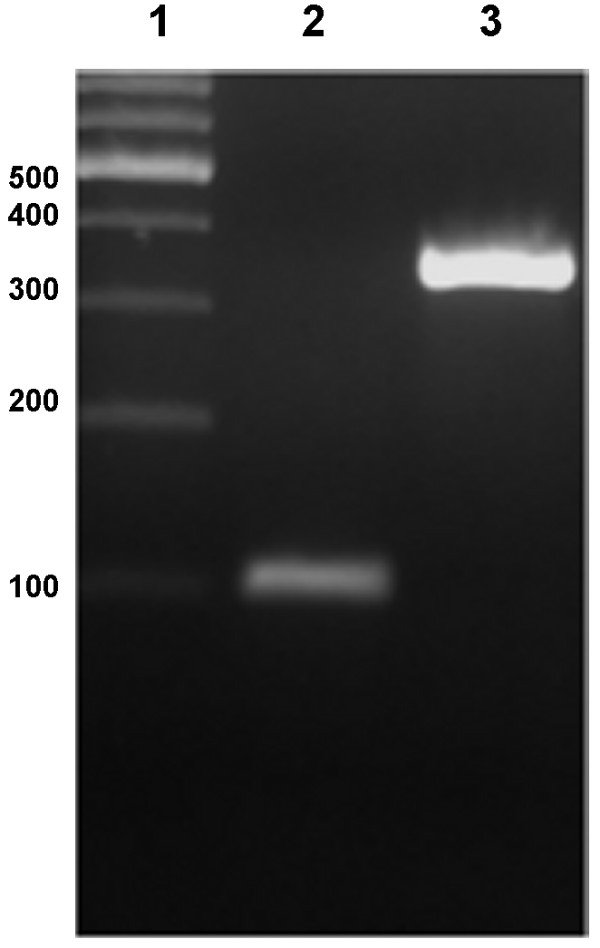
PCR amplification of part of the eae gene comprising the deleted 248 bp fragment, using primers 248 FOR and 248 REV. The amplification product of the mutant strain 97/241.6Δeae is shown in lane 2, and that of the wild-type 97/241.6 strain in lane 3. A 100 bp GeneRuler (Fermentas) was used as a size-marker (lane 1).